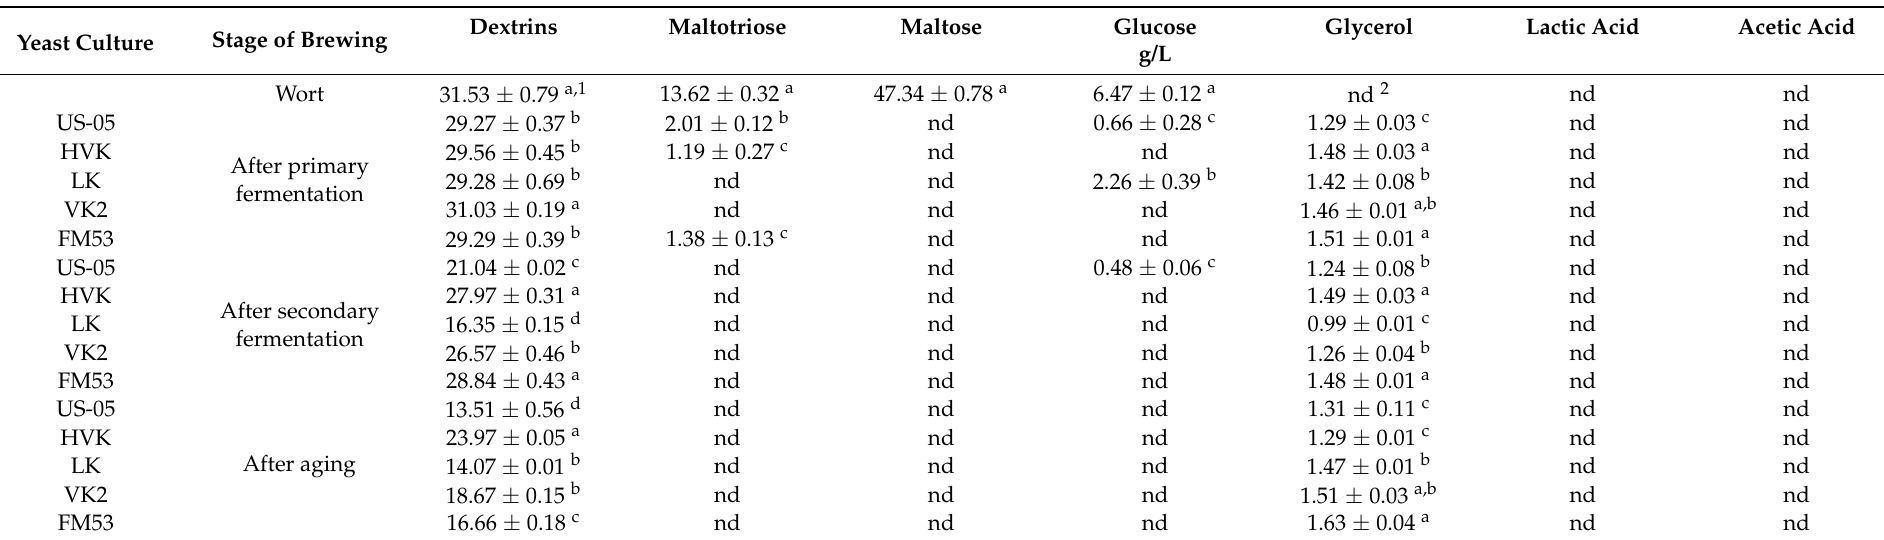
Table 2. Concentrations of starch hydrolysis products (glucose, maltose, maltotriose, and dextrins) and glycerol in the